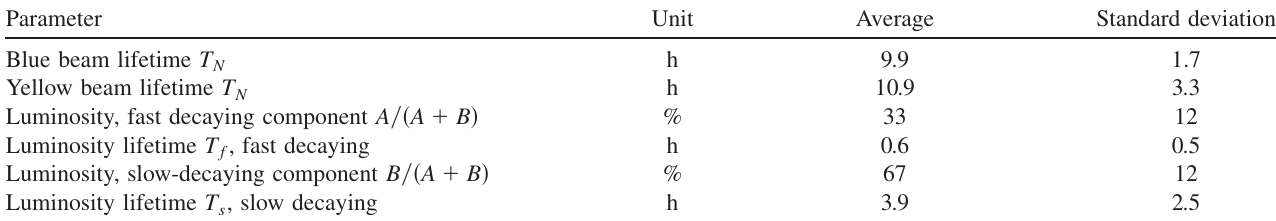
TABLE II. Average and rms values of fitted lifetime parameters for all 191 physics stores of RHIC run-7.